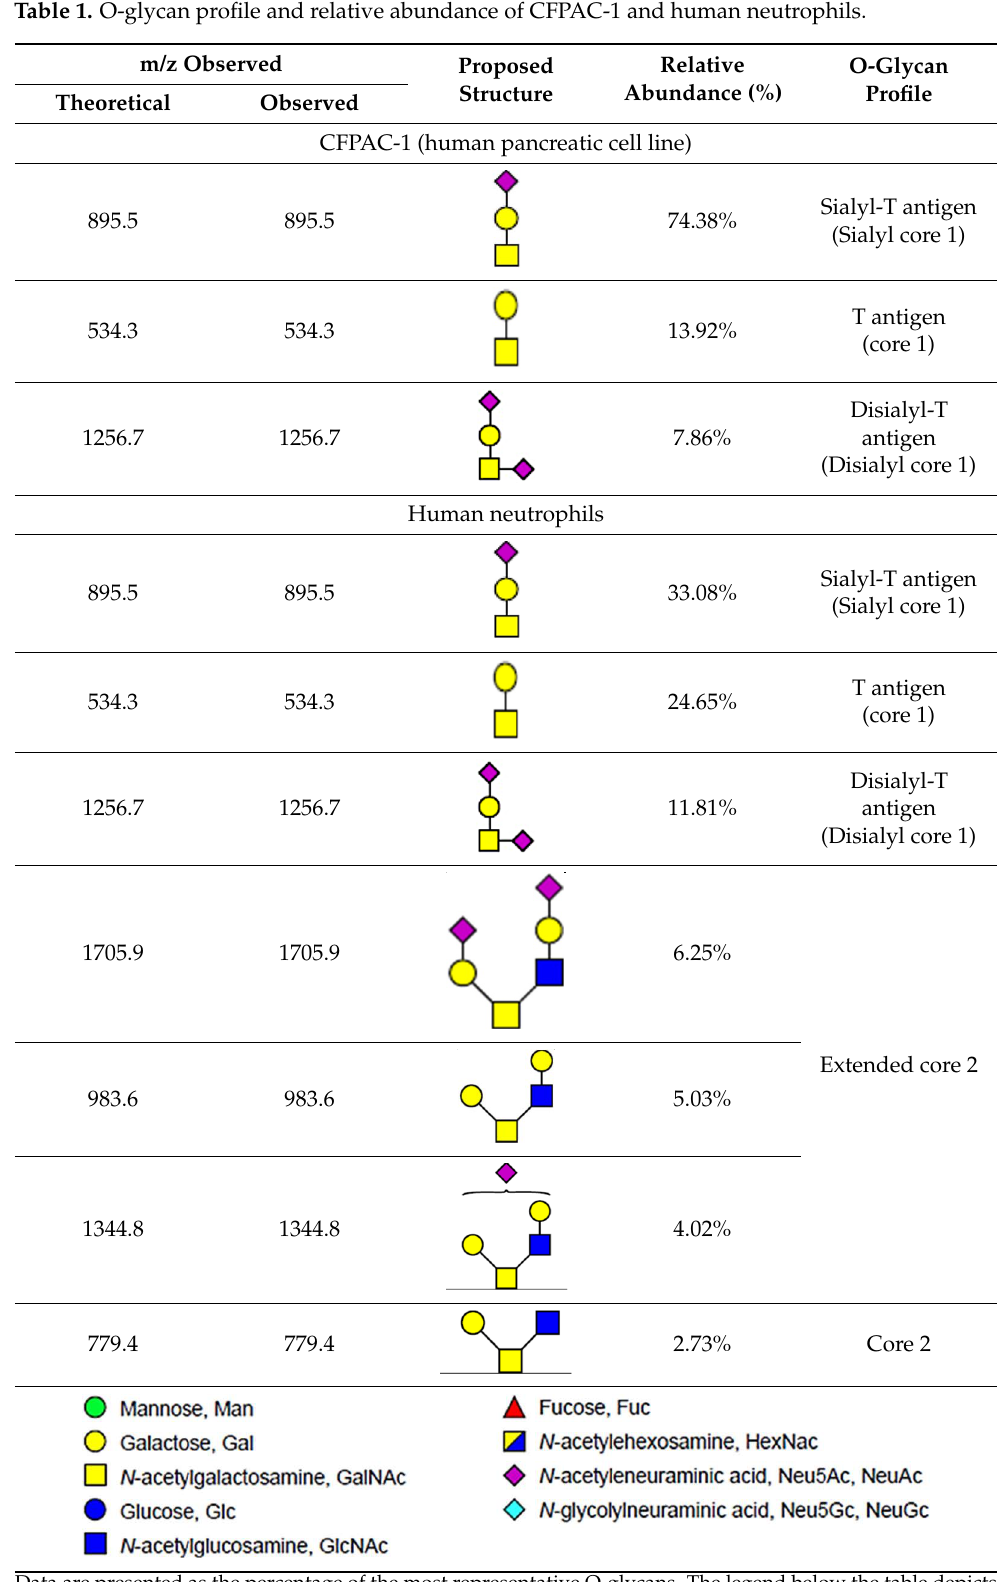
Table 2. O-glycan profile and relative abundance of HL-60, U937 and K562 cell lines.